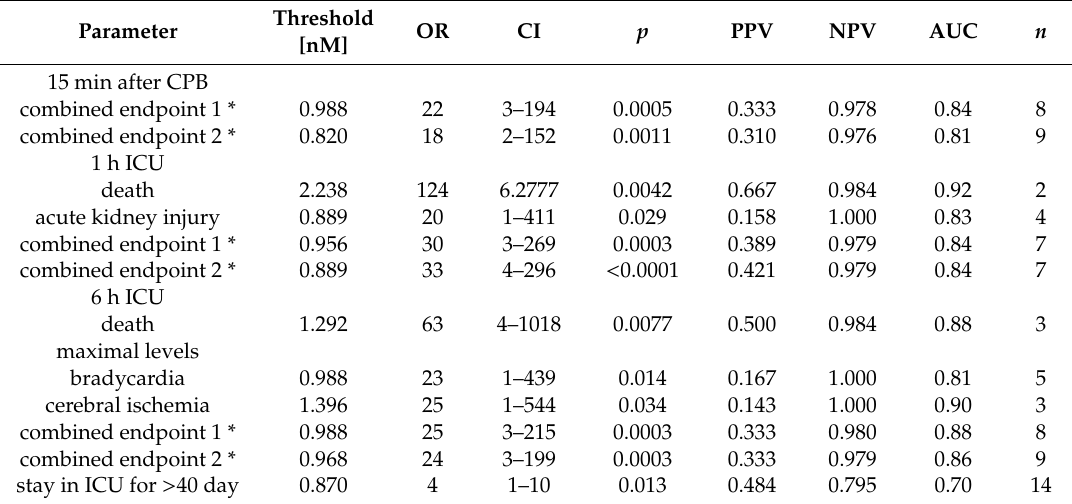
7 of 12 Table 2. Association of elevated serum SELENBP1 concentrations with adverse outcomes.